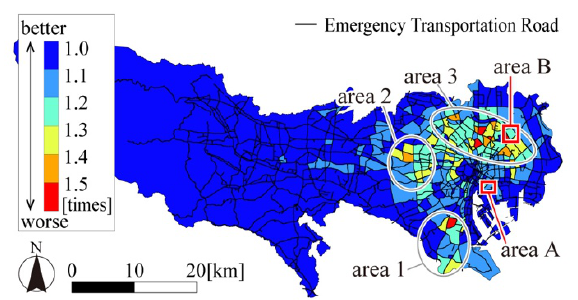
Figure 11. Spatial distribution of TTI